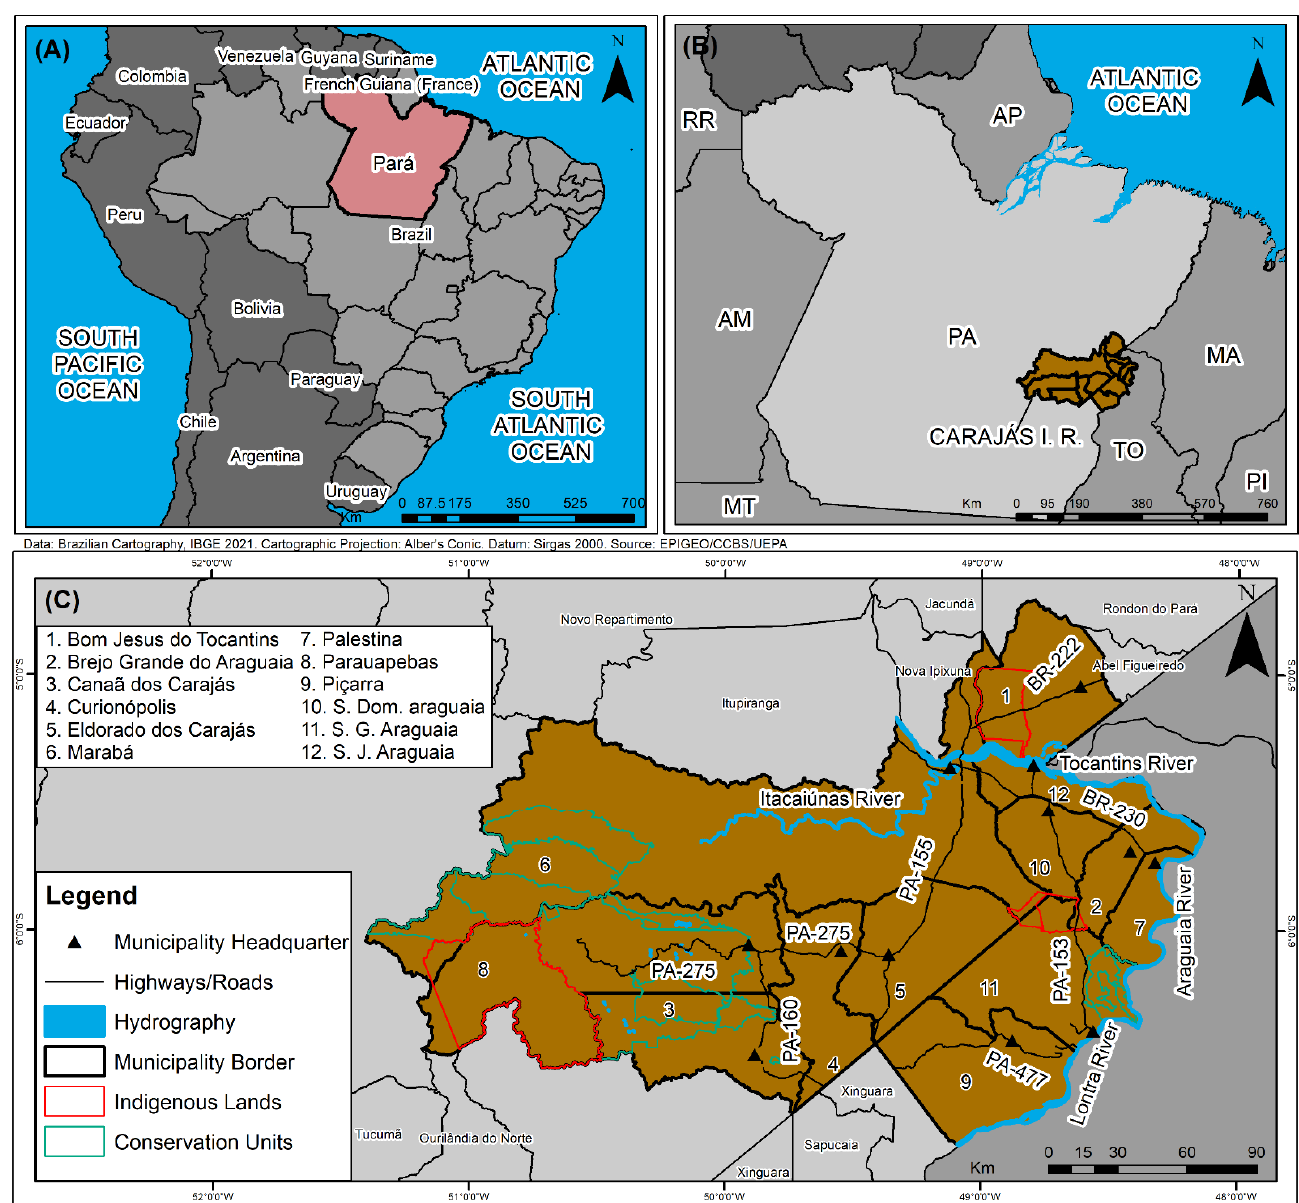
Figure 1. Spatial location of Pará ( A , red polygon), Carajás Integration Region ( B , brown polygon), and CIR municipalities map ( C ), Pará, Brazil.